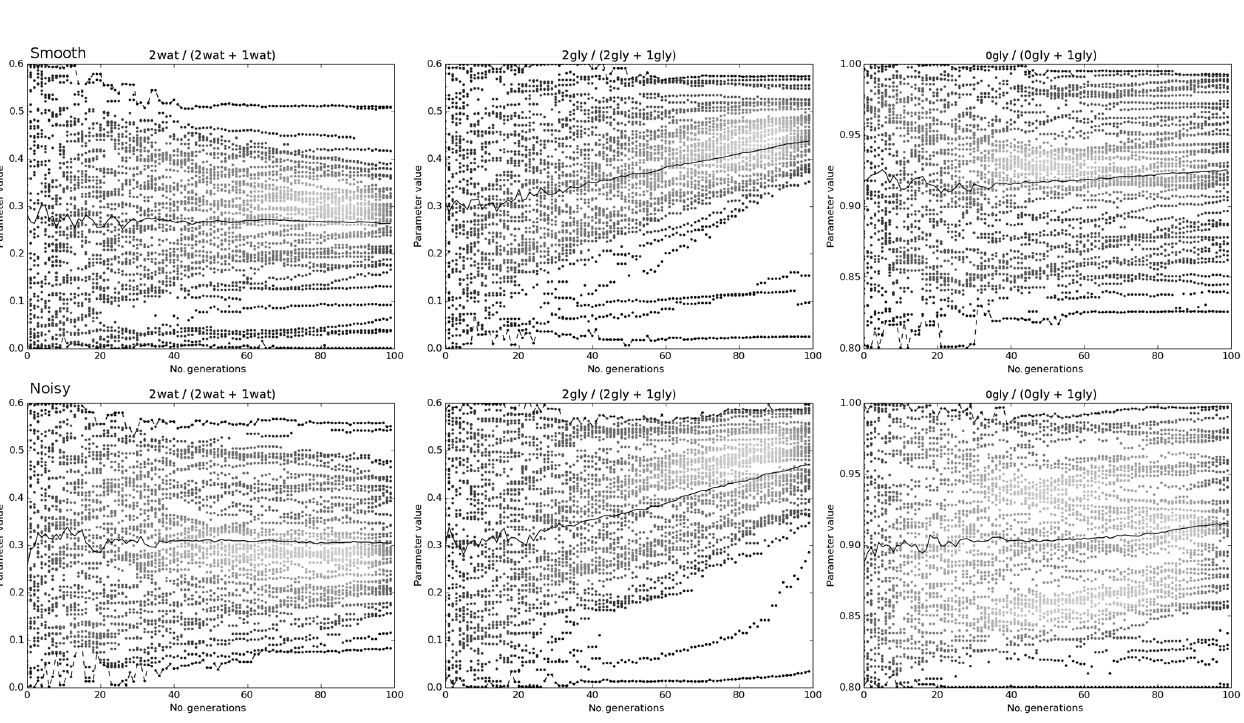
Figure 7. Parameter evolution plots for the smectite fractions in the kaolinite–smectite mixed layer of assemblage 2 using the multi-specimen set-up. Plots for the smooth patterns are in the top row, for noisy patterns in the bottom row. Legend as in Fig.